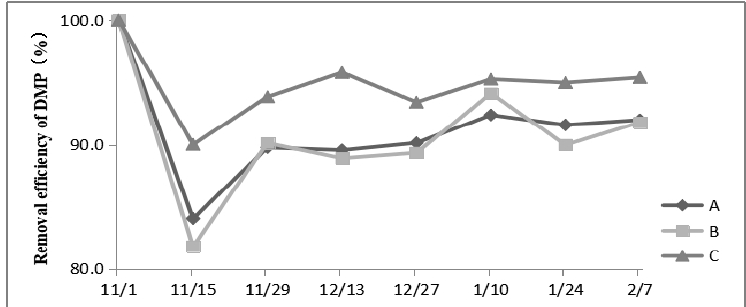
Figure 2. Dimethyl phthalate (DMP) removal efficiency in three VFCW.